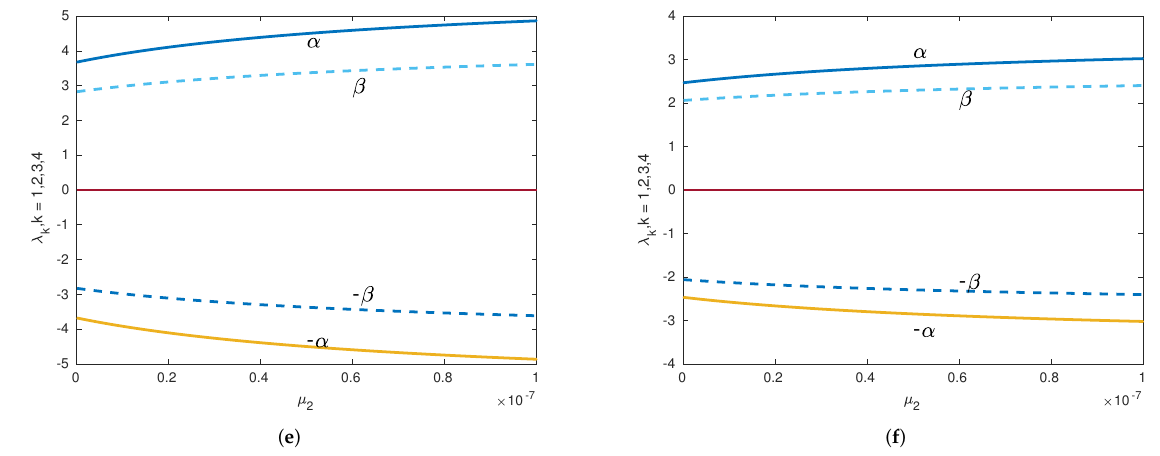
Figure 7. Eigenvalues versus µ 2 ∈ ( 10 − 10 ,10 − 7 ) of the Sun–Saturn system in the presence of the Kuiper belt effect for collinear equilibrium points with µ 1 = 10 − 7 . Continuous lines indicate the real parts of the eigenvalues, and dashed lines denote the imaginary parts of the eigenvalues for collinear points. ( a ) Eigenvalues versus µ 2 of equilibrium point left to L 1 . ( b ) Eigenvalues versus µ 2 of equilibrium point right to L 1 . ( c ) Eigenvalues versus µ 2 of equilibrium point left to L 2 . ( d ) Eigenvalues versus µ 2 of equilibrium point right to L 2 . ( e ) Eigenvalues versus µ 2 of equilibrium point left to L 3 . ( f ) Eigenvalues versus µ 2 of equilibrium point right to L 3